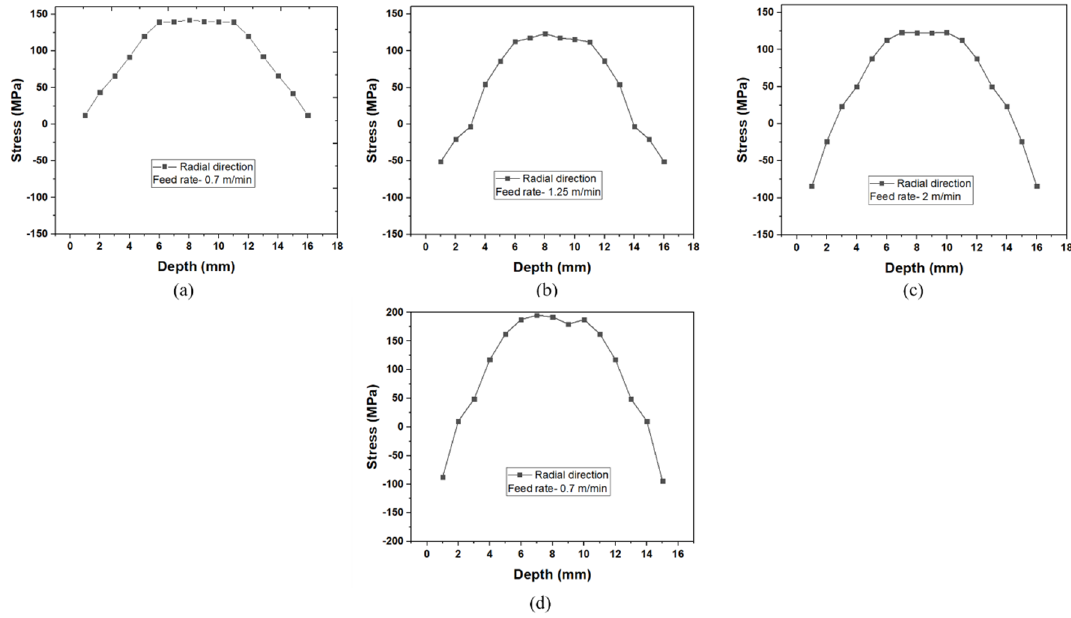
Figure 11. The residual stress variation with depth for the 25% swaged samples: ( a ) 0.7 m / min, ( b ) 1.25 / min, ( c ) 2 m / min and ( d ) 0.7 m / min for the 40% swaged sample.